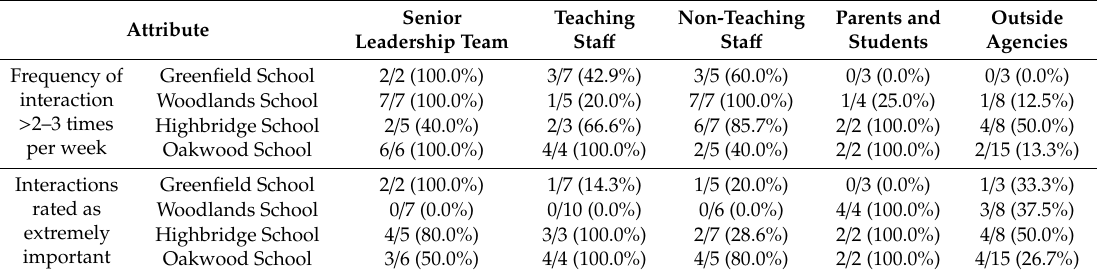
Table 6. Number (and percentage) of health and wellbeing-related interactions within each department that have been rated with a high frequency and extreme